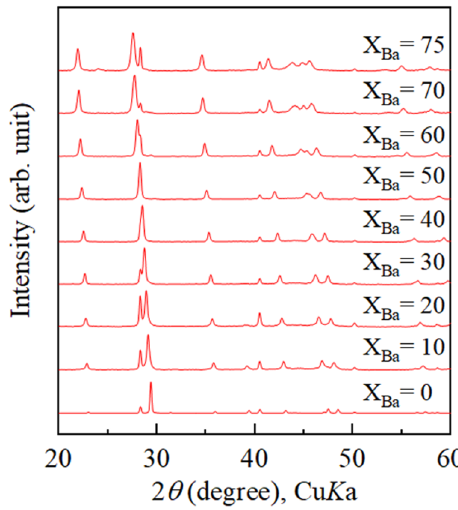
Figure 3. Powder X-ray diffraction patterns of calcium carbonate samples with various Ba concentrations obtained from heating treatment. Crystallization was induced by heating treatment at 400 °C for 2 h. x Ba stands for Ba/(Ba + Ca) of starting solutions.